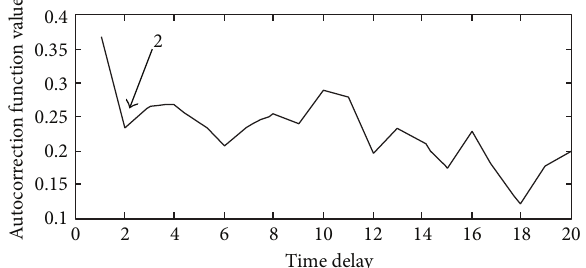
Figure 19: Selection of the delay time by the autocorrelation function value of LTSA1.